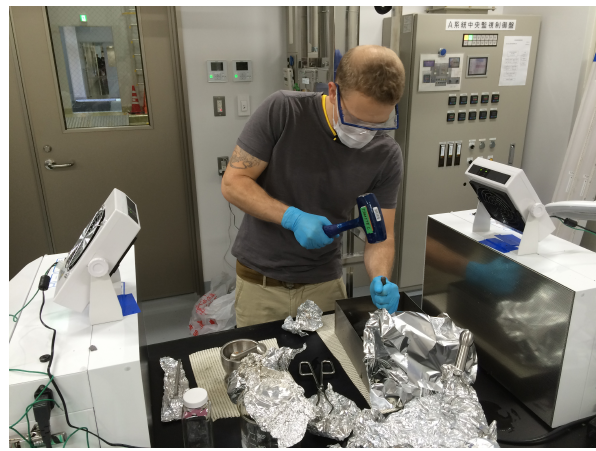
Figure 3. Example of sample homogenization within the KOACH benchtop laminar flow system at the Kochi Core Center. Photograph by Beth Orcutt.